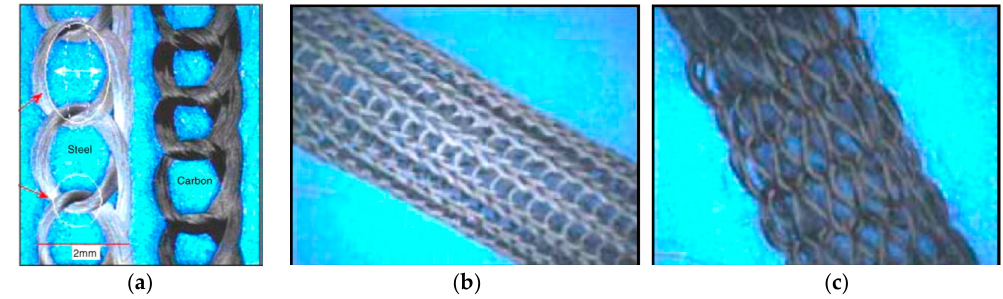
Figure 8. ( a ) Knitted single warp steel and carbon structures; ( b , c ) tubular structures [53] .